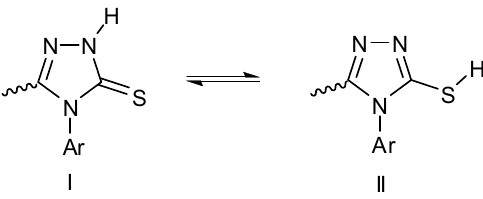
Figure 5. Thione I and thiol II tautomers of 4-amino-1,2,4-triazol-5-thione.